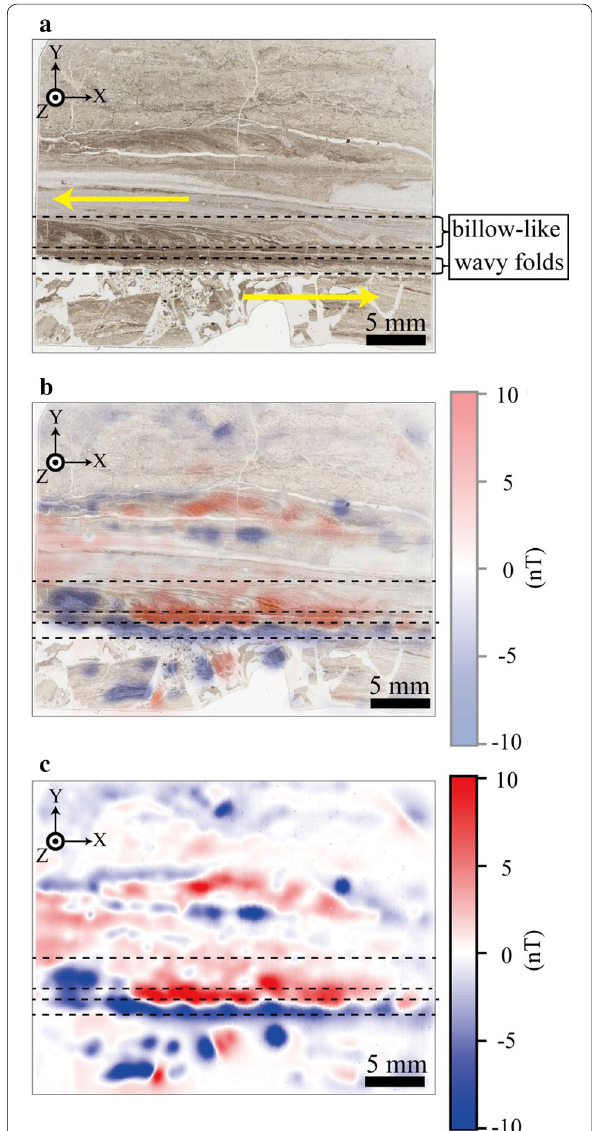
Fig. 6 a Optical image of a thin section from block sample b3 in Fig. 1e. The yellow arrow indicates a direction of fault movement estimated from the billow-like wavy folds. b A semitransparent SQUID microscopic image superimposed on the optical image. c A SQUID microscopic image of the thin section. Positive (negative) magnetic field values correspond to upward (downward) oriented